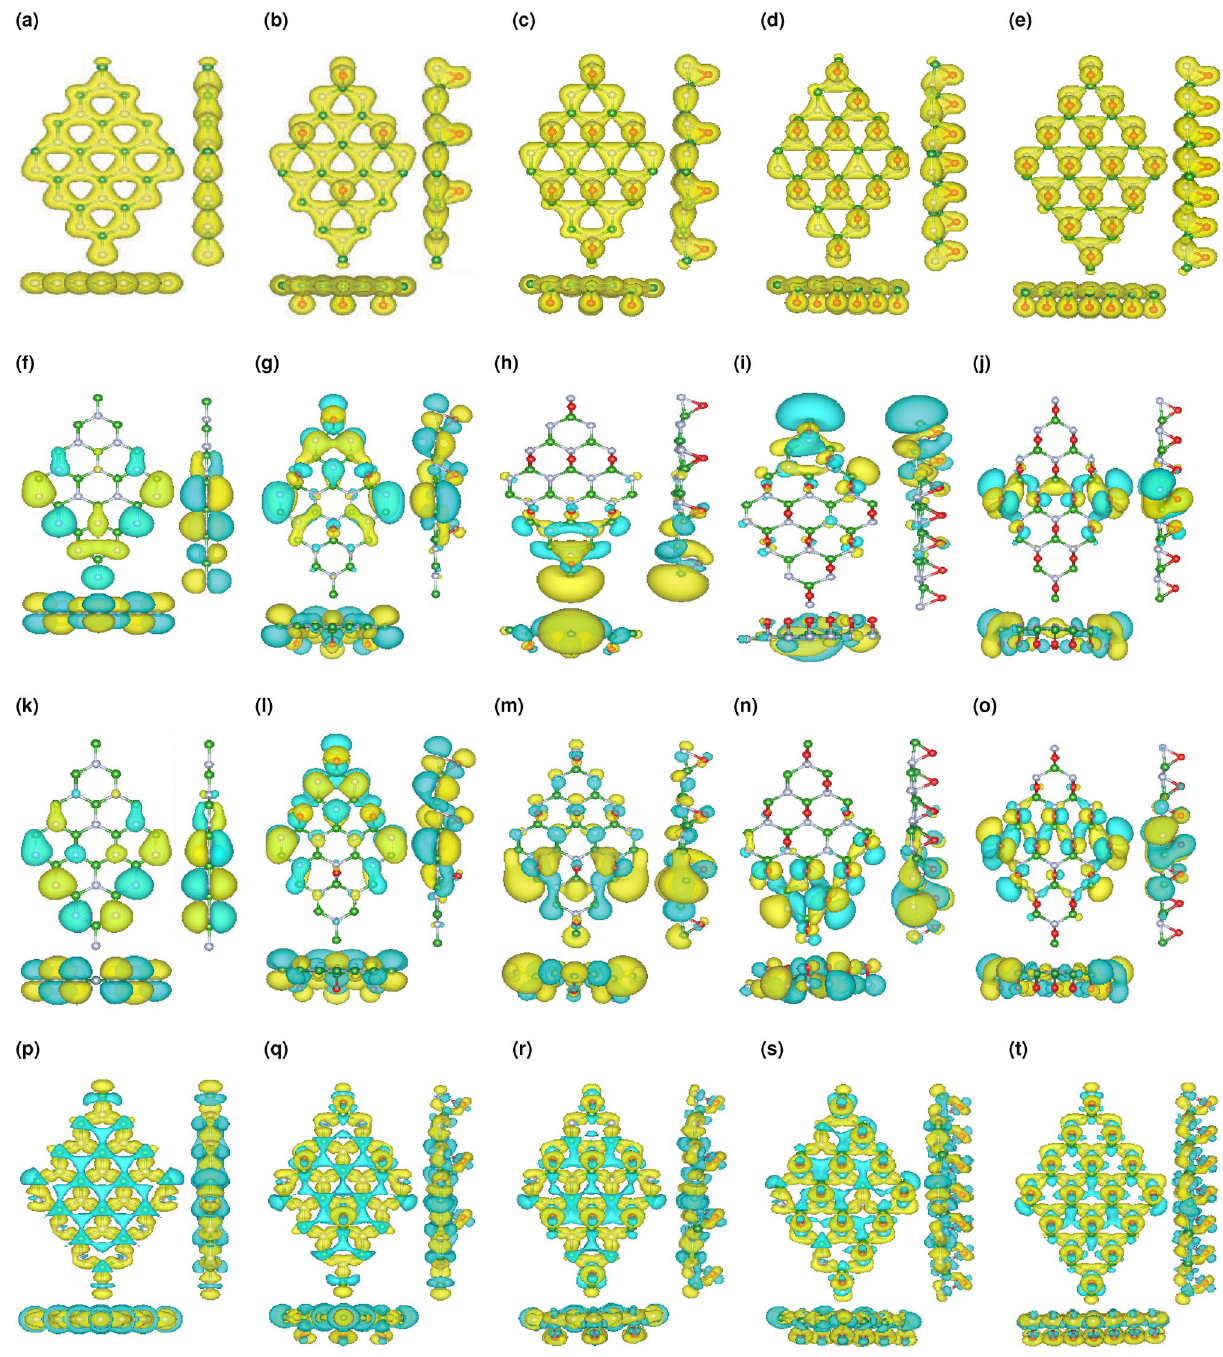
Figure 5. ( a ) Top and side view of total charge density for the pristine hBN. ( b – e ) Top and side views of total charge density for the (cid:31) = 1/8, 2/8, 3/8, and 4/8 functionalized hBN. ( f ) Top and side view of charge density at VBM for the pristine hBN. ( g – j ) Top and side views of charge density at VBM for the (cid:31) = 1/8, 2/8, 3/8, and 4/8 functionalized hBN. ( k ) Top and side view of charge density at CBM for the pristine hBN. ( l – o ) Top and side views of charge density at CBM for the (cid:31) = 1/8, 2/8, 3/8, and 4/8 functionalized hBN. ( p ) Top and side of charge density difference for the pristine hBN. ( q – t ) Top and side views of charge density difference for the (cid:31) = 1/8, 2/8, 3/8, and 4/8 functionalized hBN. The yellow regions indicate the positive value (electron accumulation) whereas, the cyan regions represent the negative values (electron depletion) The isosurface of charge densities is 3 equal to 0.01 e/Å